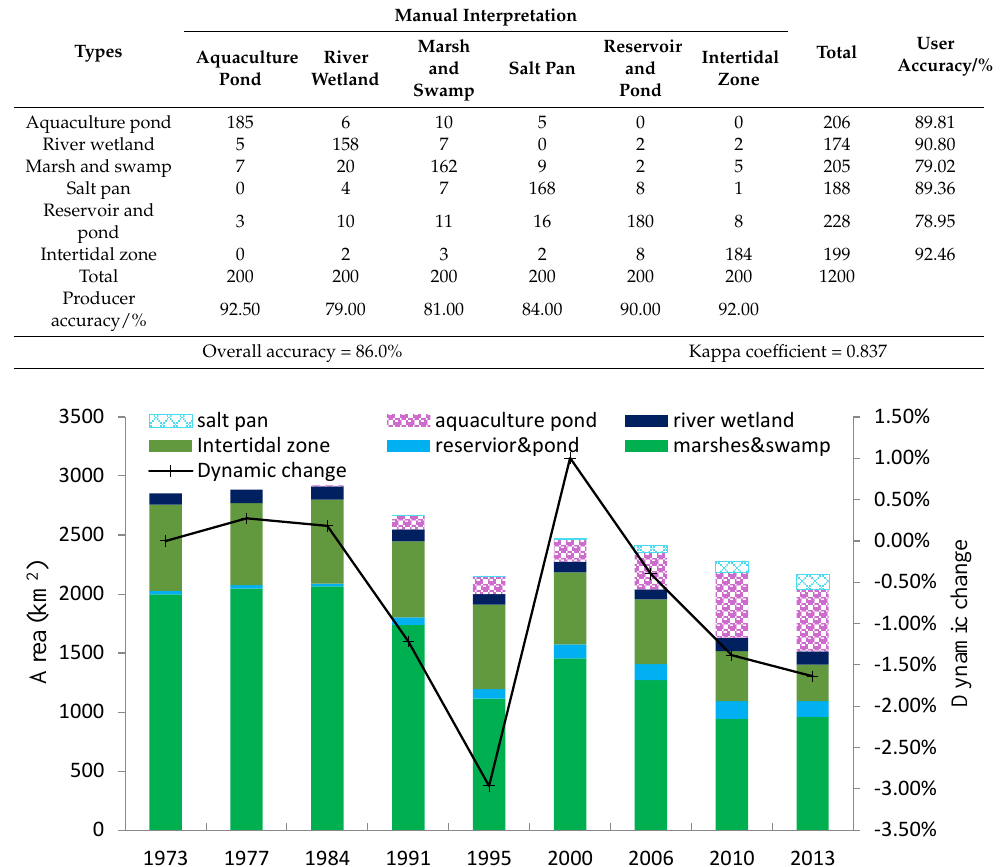
Table 4. Wetlands classification accuracy evaluation in 2013.